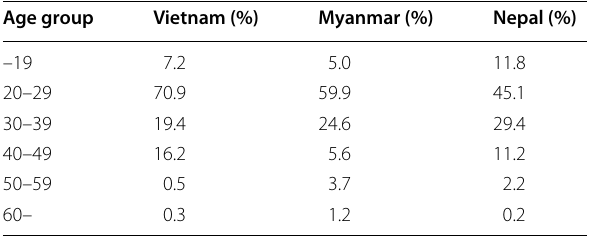
Bold indicates the three nationalities, because the three nationalities are the ones we focused in our activities